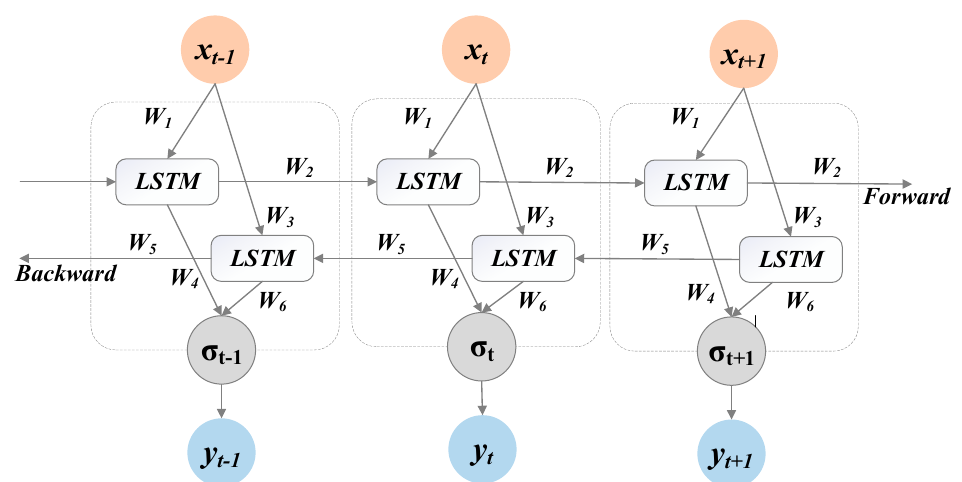
Figure 2. Structure diagram of Bidirectional Long Short-Term Memory (BiLSTM).